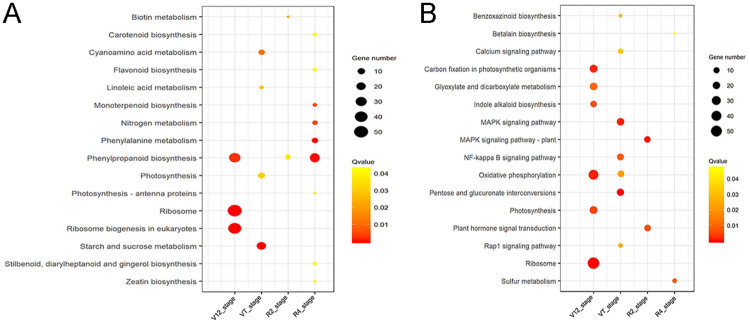
KEGG pathway enrichment analysis of DEGs.Sub-figures show the most significantly enriched KEGG pathways in (A) ND476; and (B) ZX978 genotypes across the four crop growth stages.